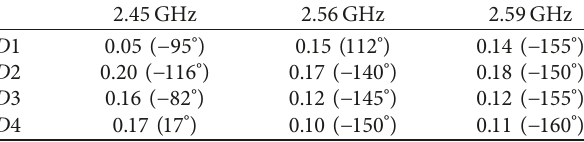
Table 3: The weights of each element of the dipole antenna.